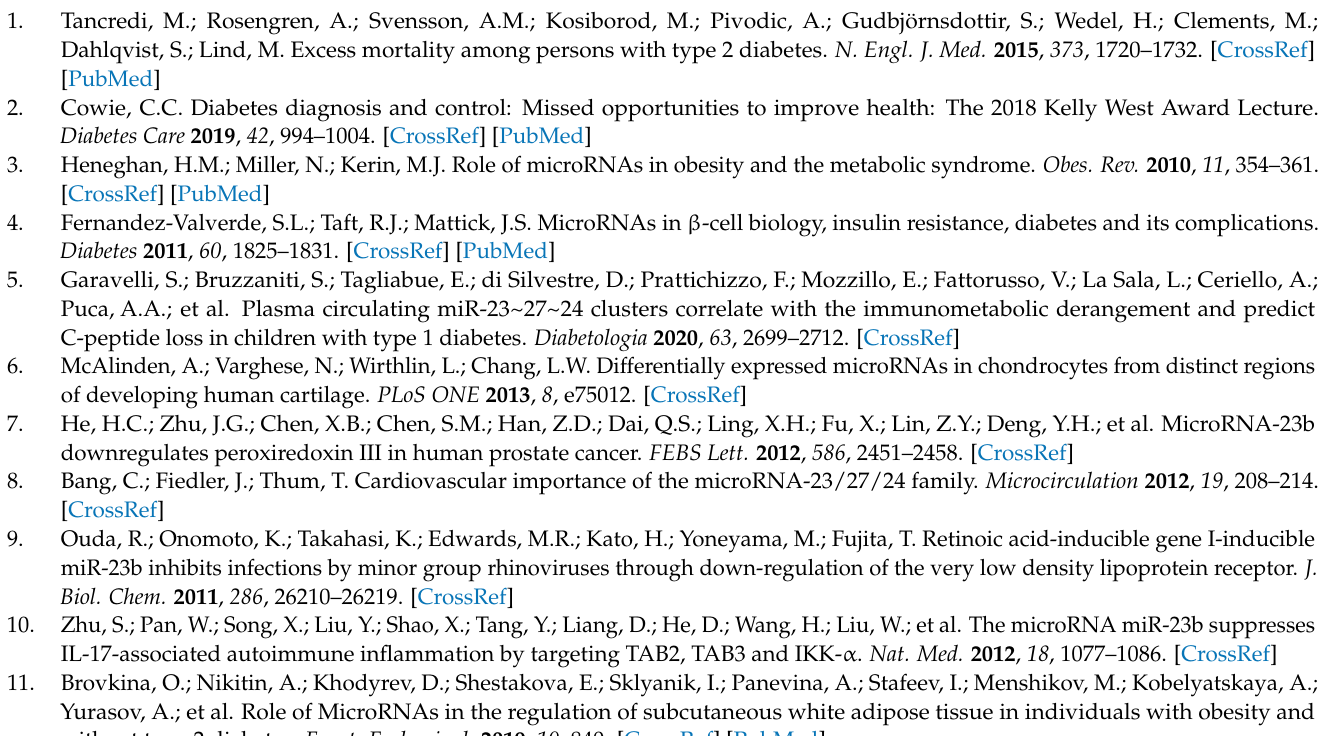
Figure S4: Validation of RNA-seq results, Table S1: Primer sequences for quantitative real-time PCR, Table S2: Differential metabolites identified by non-targeted metabolomics Table S3: All differentially expressed genes, Table S4: Genes involved in the glycolysis